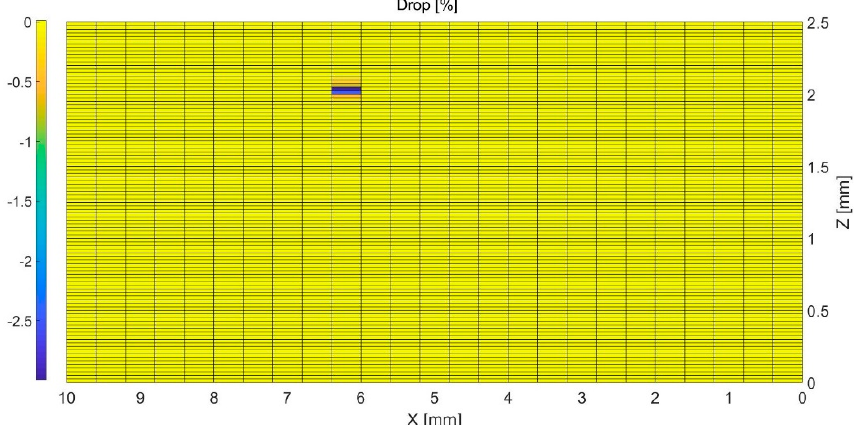
Figure 10. 2D plot of the drop at the XZ plane for crack1 (50 μ m).